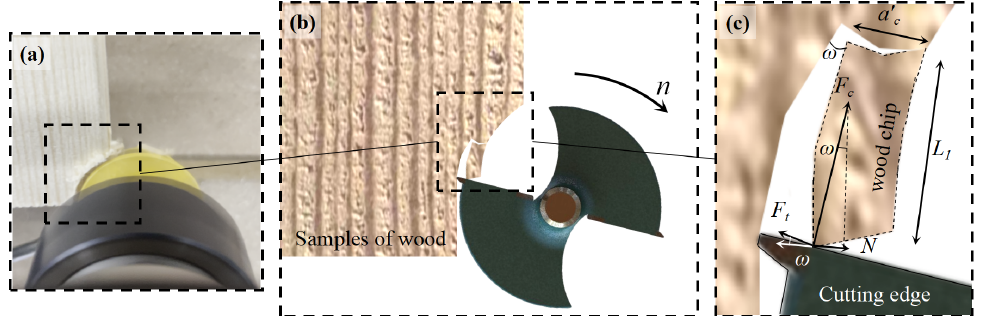
Figure 3. Top view of wood circumferential milling and force analysis. ( a ) The actual circumferential milling process of the machine. ( b ) A theoretical illustration of the wood circumferential milling process. ( c ) A local enlarged view of the wood chip formation area. The wood chip length denoted by L 1 and the cutting depth represented by a’ c have been amplified for labeling ease.